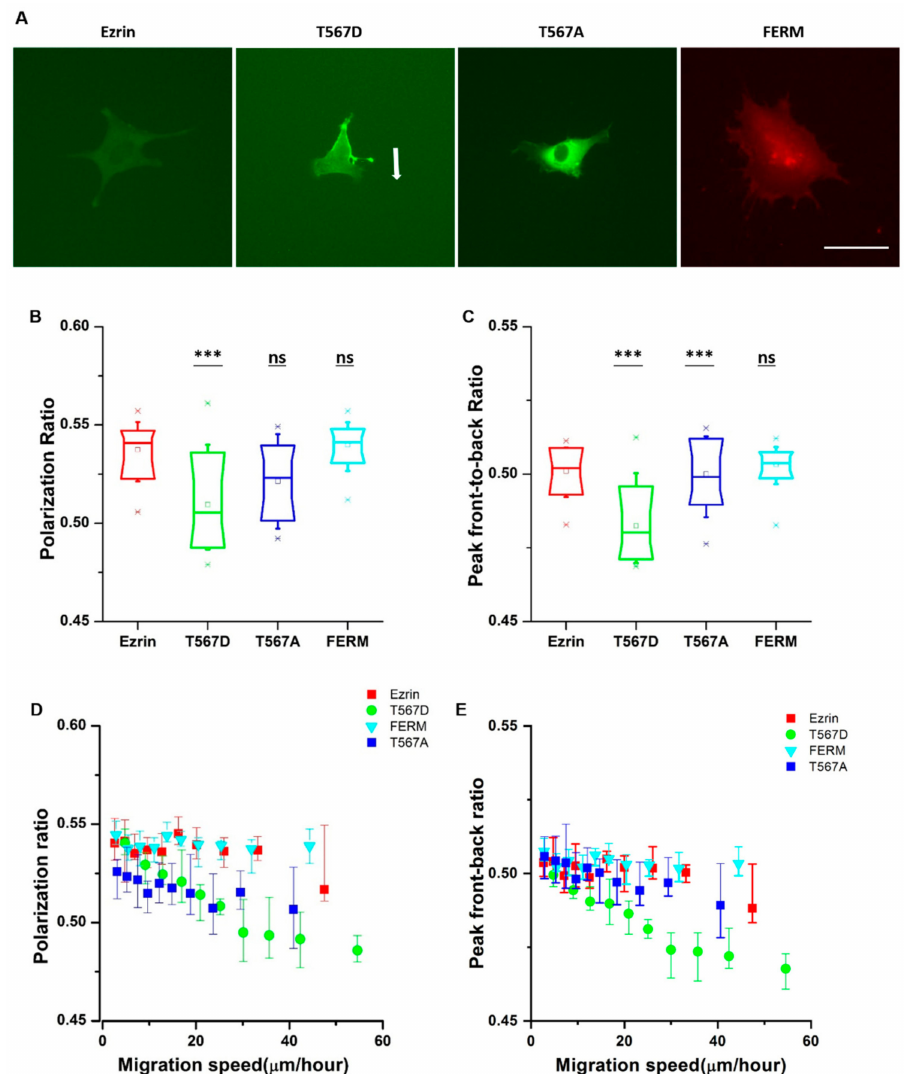
Figure 2. The subcellular distribution of ezrin and its mutations during migration. ( A ) Example fluorescent images of transfected cells obtained from the time-lapse videos. The example cell for ezrin T567D showed clear persistent directional migration, indicated by the arrow. The other example cells showed no clear directional migration. Scale bar 50 µ m. Box plots show the results of the polarization ratio ( B ) and peak front-to-back ratio ( C ). Box plots extend from the 10th to the 90th percentile, whiskers from the 5th to the 95th. The plot shows the relationship between the cell migration velocity and the polarization ratio ( D ) and peak front-to-back ratio ( E ), error bars indicate SD. A total of n = 21 (ezrin), n = 45 (ezrin T567D), n = 52 (ezrin T567A), and n = 60 (FERM) cells were analyzed from n = 4 repeats. Asterisks indicate a statistical di ff erence (*** p < 0.001, obtained using Dunnett’s test against wild-type